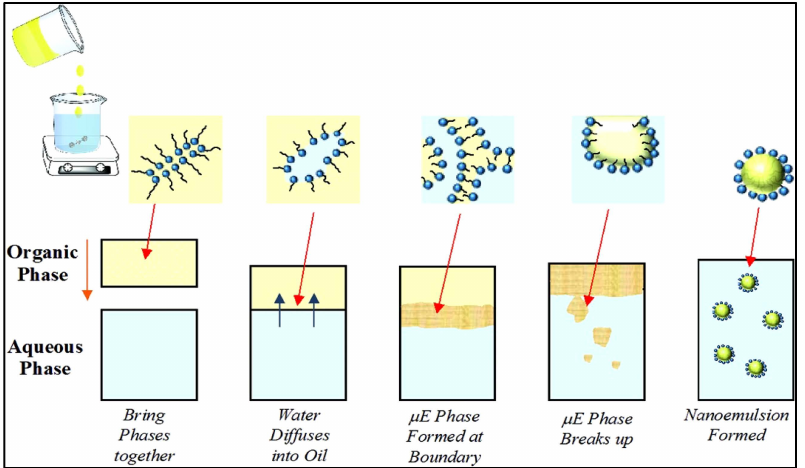
Figure 5. Mechanism of micelle formation in a nanoemulsion system utilizing the spontaneous emulsification method